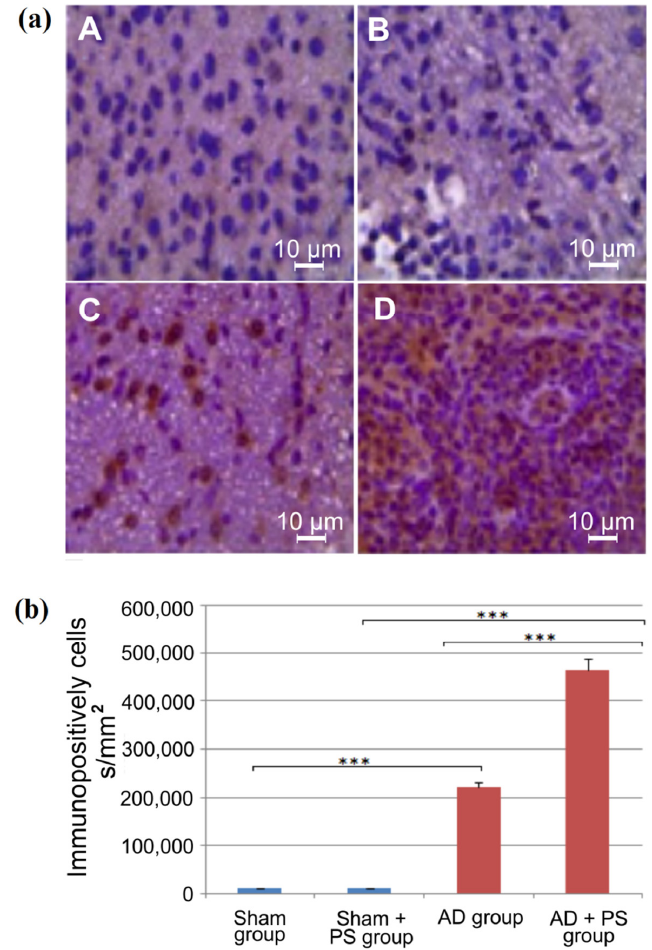
Figure 3. ICH analysis of A β plaques in the deep cervical lymph nodes (dcLNs) before and after PS: ( a ) A and B—ICH image does not show A β plaques in the dcLN in the sham groups; C and D—ICH image shows few A β plaques in the AD group and a significant A β level in the AD + PS group ( n = 10 in each group); ( b ) The quantitative study of A β level in the dc LNs in the tested groups: ***— p < 0.001 vs. the sham groups, n = 10 in each group.